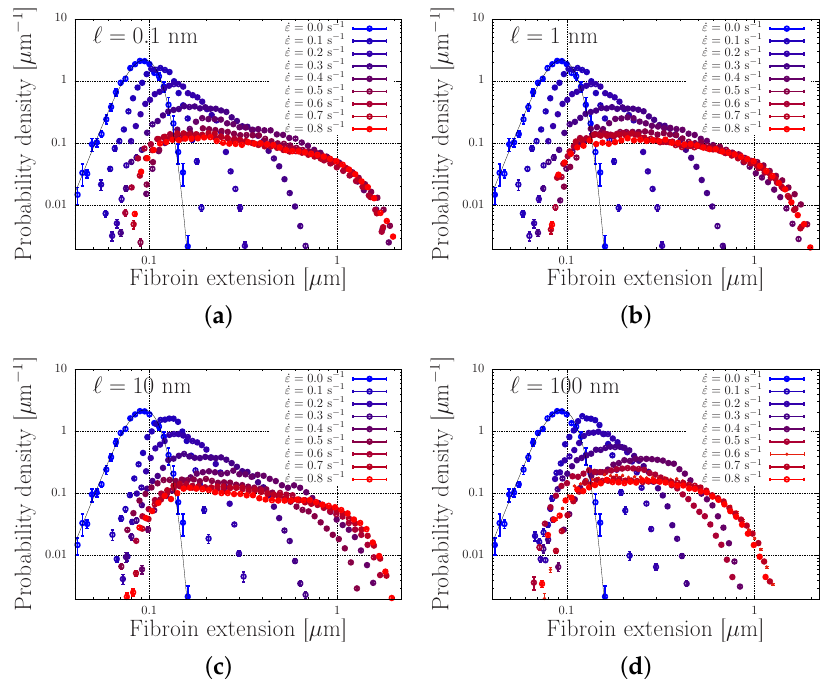
Figure 7. Distribution of chain lengths at various extensional flow rates. The solid curve corresponds to the expected Gaussian distribution when the entanglements are aligned with the flow without further stretching. In the four panels ( a – d ), the dissociation length is (cid:96) = 0.1, 1, 10 and 100 nm, respectively. The parameter values are specified in Table